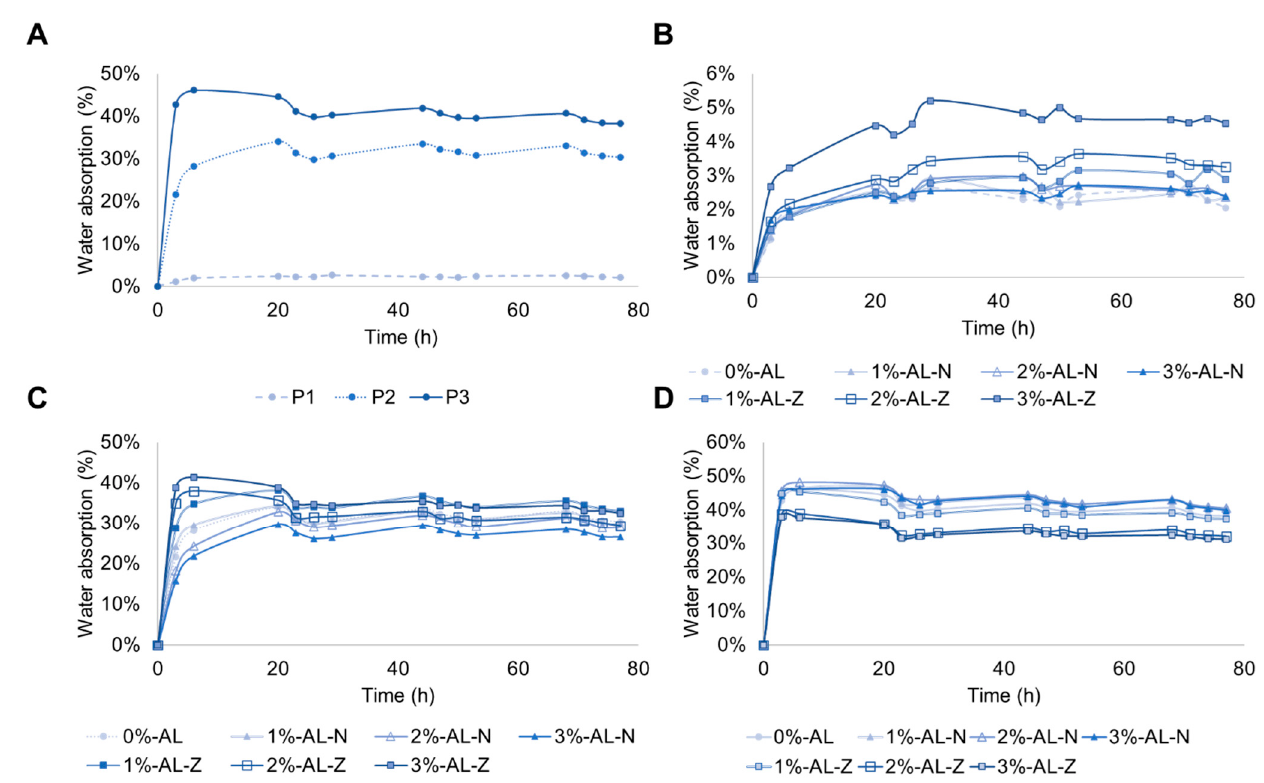
Figure 4. Water absorptions kinetics of ( A ) PU matrices without fillers, ( B ) P1, ( C ) P2, and ( D ) P3 composites.